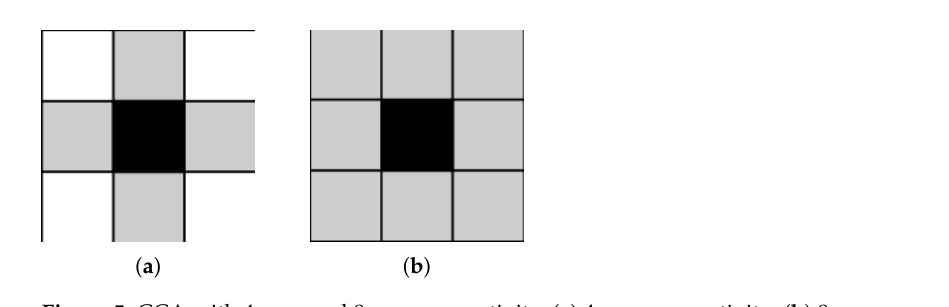
Figure 5. CCA with 4-way and 8-way connectivity. ( a ) 4-way connectivity; ( b ) 8-way connectivity.